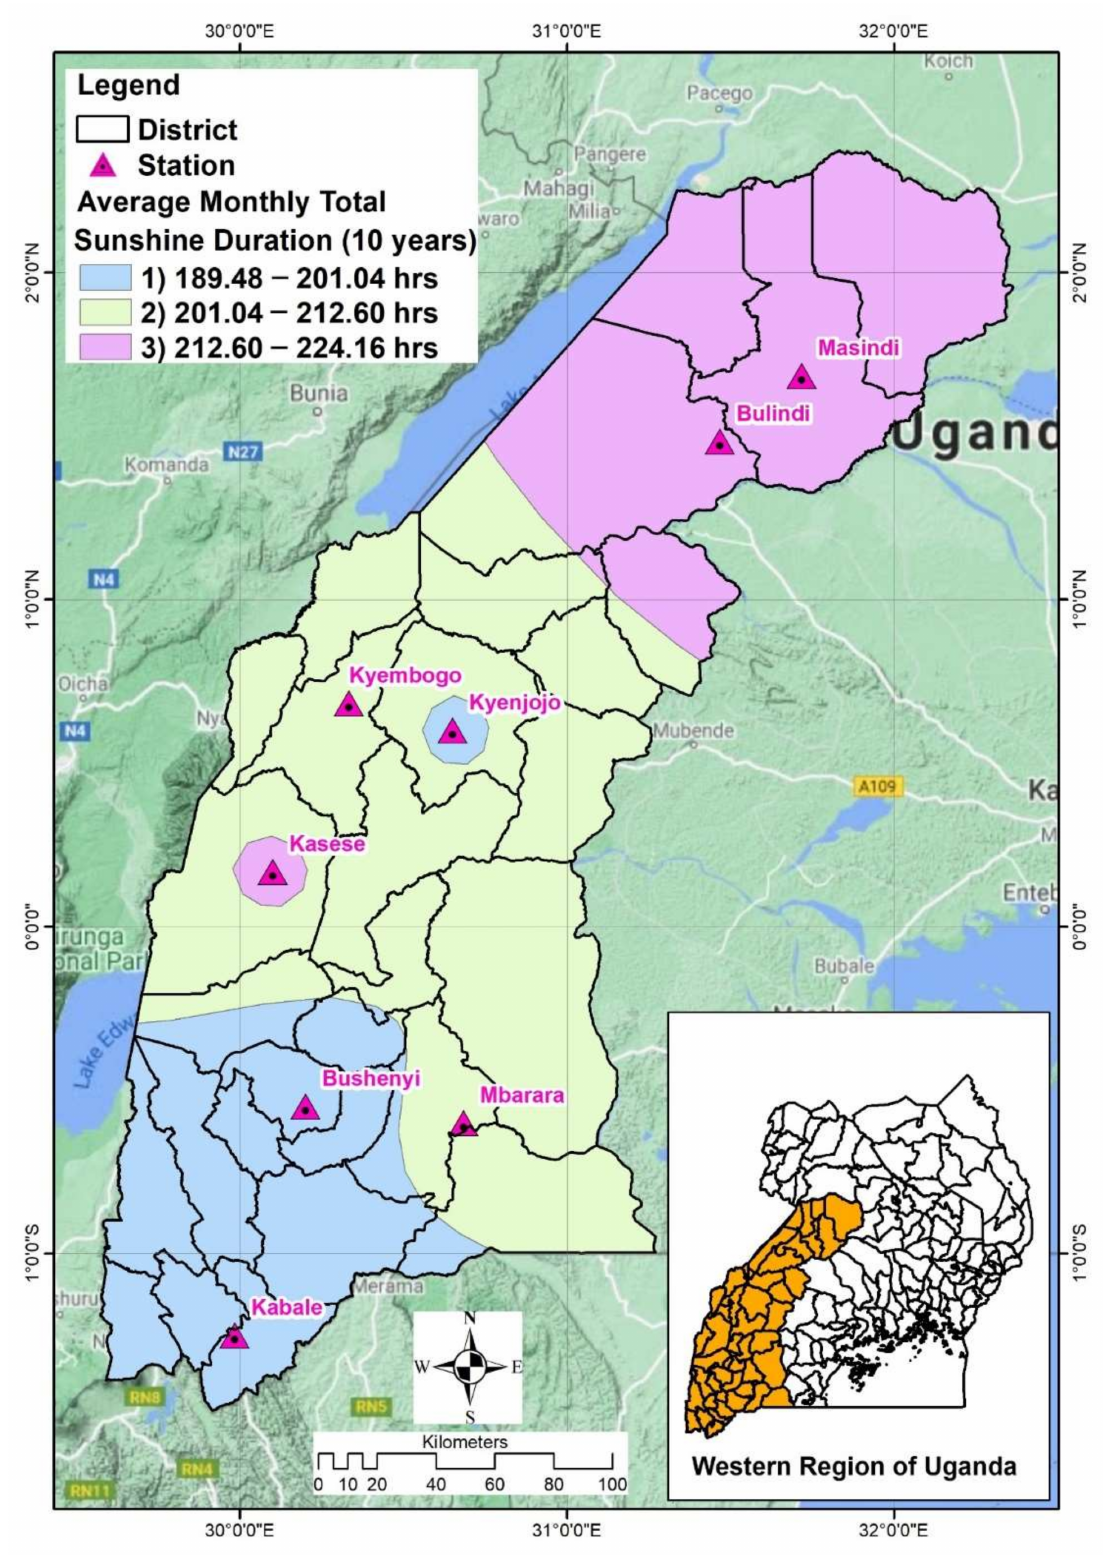
Figure 11. Map showing sunshine distribution in the study